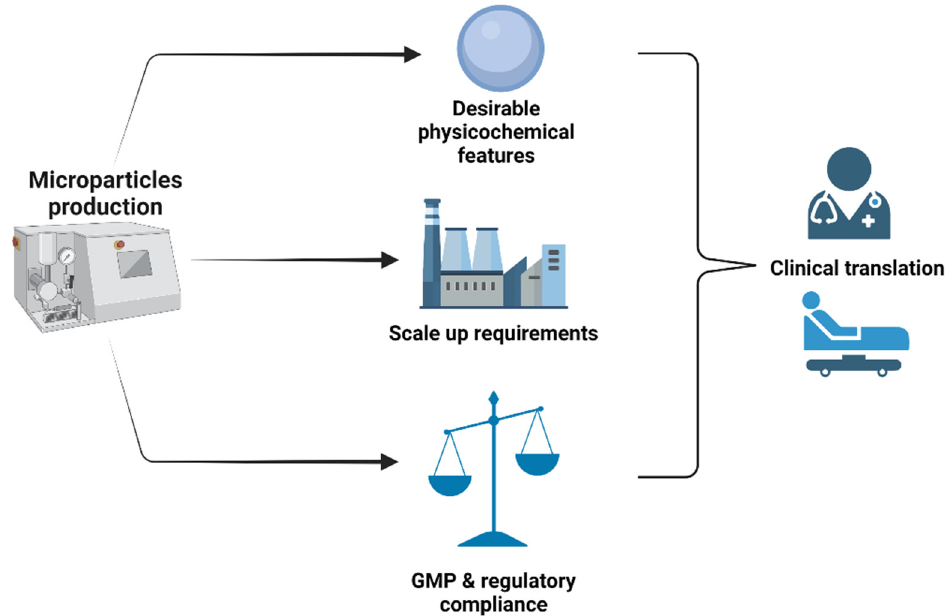
Figure 2. Schematic illustration representing the main three aspects to be taken under consideration while selecting a fabrication technology for microparticles. Created by BioRender.com (accessed on 23 February 2022).